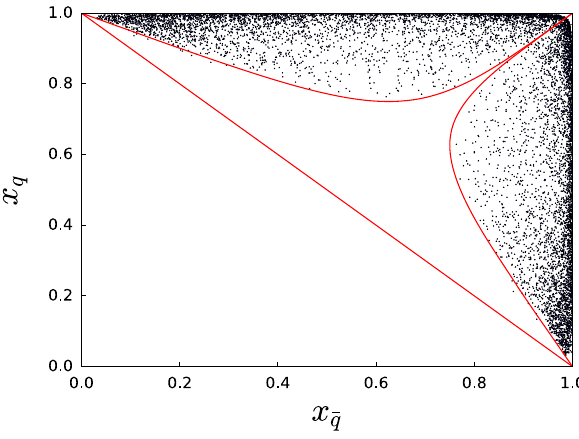
Fig. 5 Dalitz plot for e + e − → q ¯ q showing the region of phase space filled after multiple emission from the quark and antiquark in the angular-ordered parton shower. The virtuality of the branchings was preserved in the case of multiple emission. The line shows the limits for the parton-shower emission for a single emission. x i = 2 E i / Q